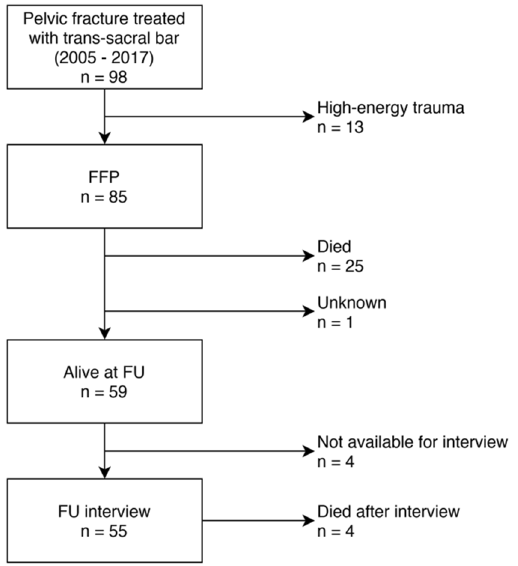
Figure 1. Flow diagram with patient inclusion and follow-up. FFP fragility fracture of the pelvis, FU follow-up. Graphic produced with draw.io (accessed